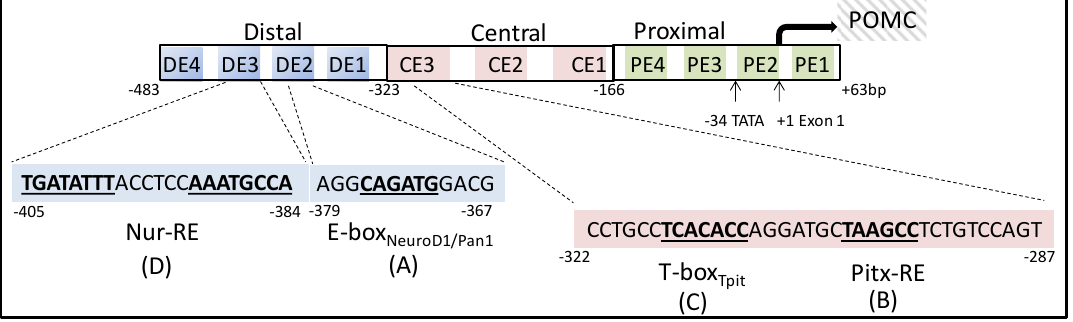
Figure3. DepictionoftranscriptionalregulationofPOMCpromoterbycorticotroph-lineagespecific Figure 3. Depiction of transcriptional regulation of POMC promoter by corticotroph-lineage transcription factors. ( A ) E-box, NeuroD response element; ( B ) Pitx-RE, Pitx1 response element; specific transcription factors. T-box, Tpit response element; Pitx-RE, Pitx1 response element; E-box, ( C ) T-box, Tpit response element; ( D ) Nur-RE, Nur-factor binding NeuroD response element; Nur-RE, Nur-factor binding element.